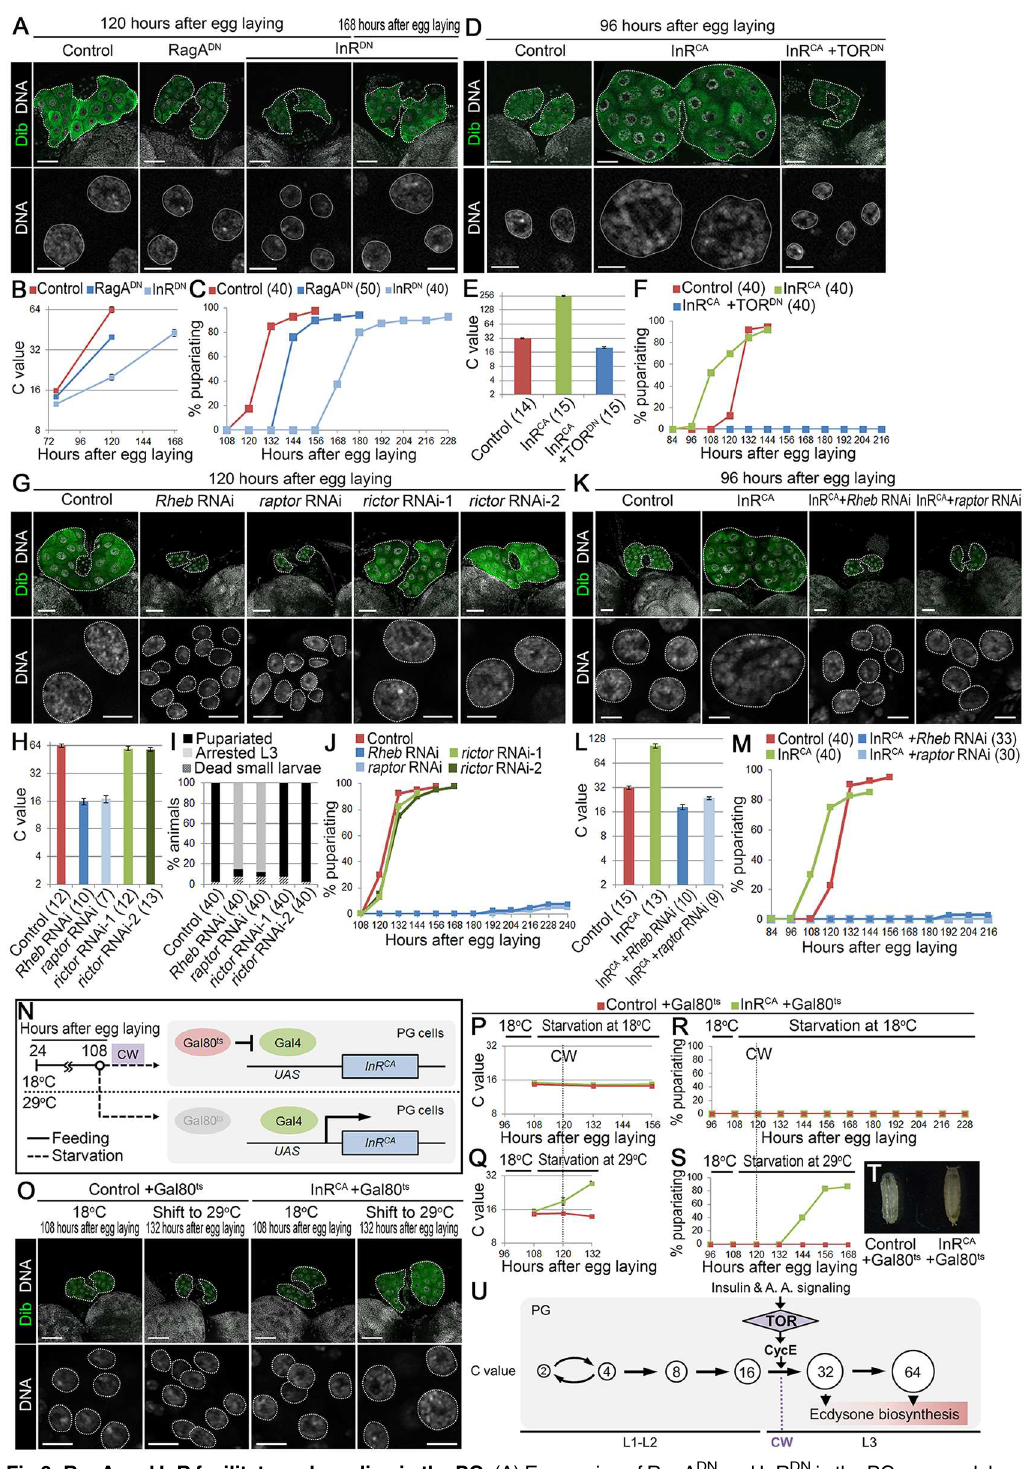
Fig 6. RagA and InR facilitate endocycling in the PG. (A) Expressionof RagA DN and InR DN in the PG causes delay in DNA content increase.The PGs (upper panels,outlined)and nuclei of PG cells (lowerpanels, outlined)in control ( phm22 > + ), RagA DN ( phm22 > RagA . T16N ) and InR DN ( phm22 > InR . K1409A ) animalswere labeledfor Dib (green) and DNA (white) at indicatedstages. Scale bars, 50 μ m (upper panels) and 10 μ m (lower panels). (B) The C value of PG cells of control, RagA DN and InR DN larvaeat indicatedstages. Average C value of control at 120 hAEL